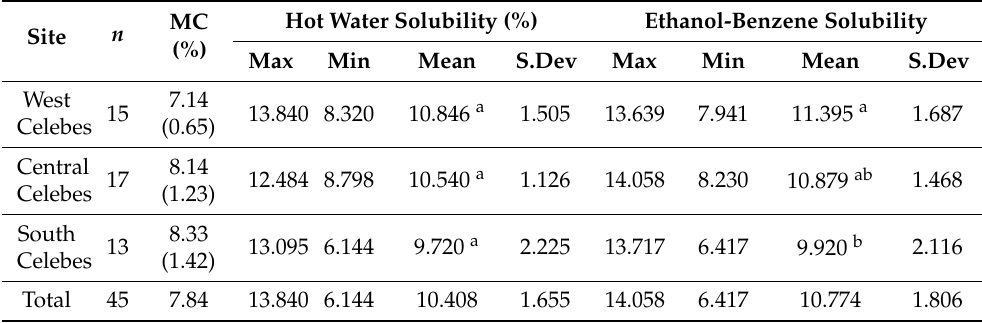
Table 1. Extractive content in different solvent on ebony wood from South Celebes, West Celebes, Table 1. Calibration and validation model for extractive content of ebony wood. and Central